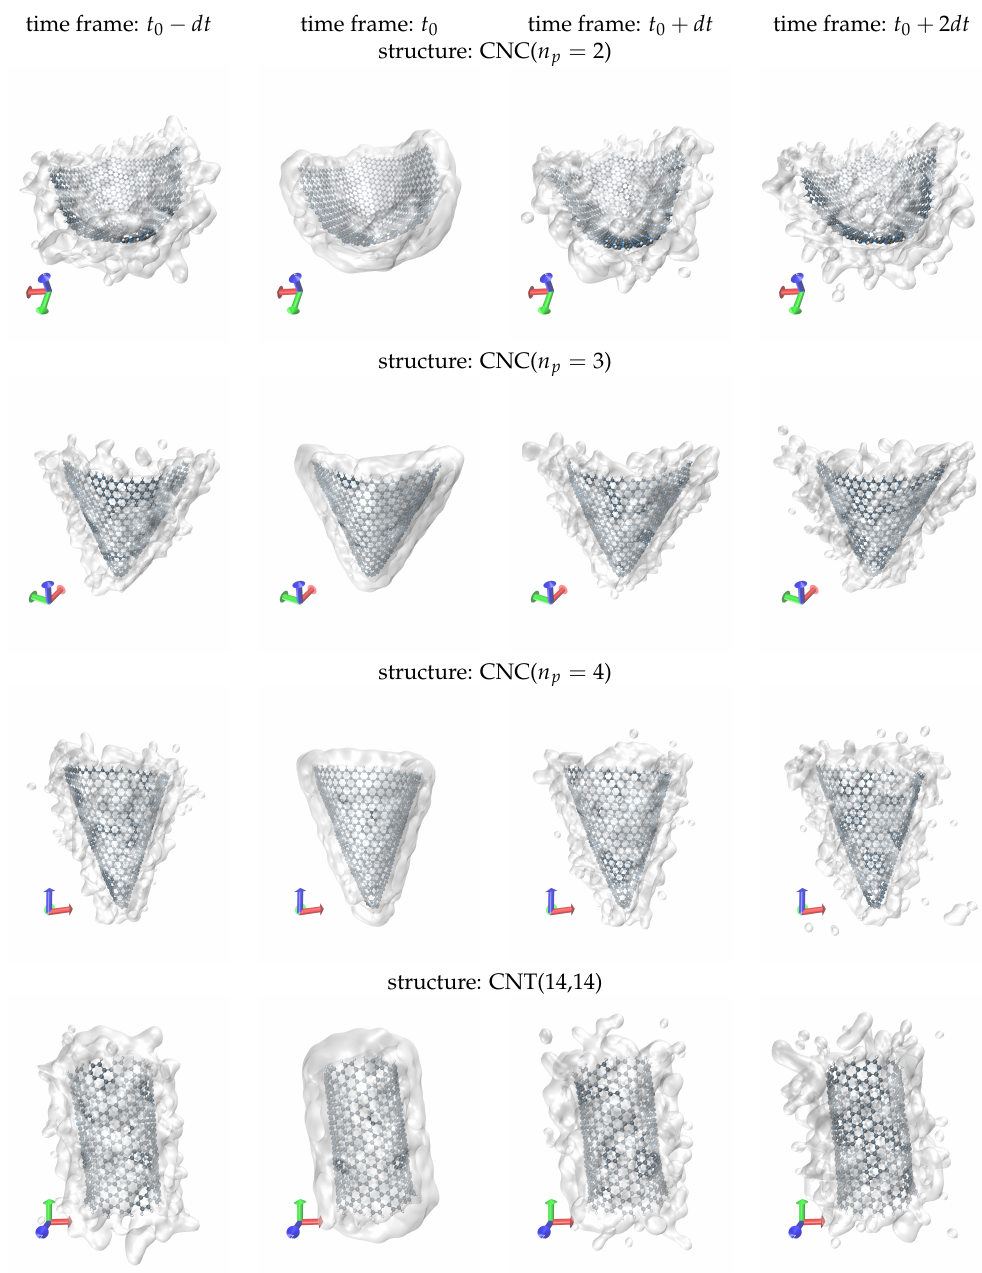
Figure 4. Screenshots showing the hydration shell of the nanoparticles (water layer of thickness 5 Å) at different time frames of the simulation. The hydration shell is settled at t 0 . The time interval of the frames is dt = 10 ps. Only the molecules contained in the shell at t 0 are